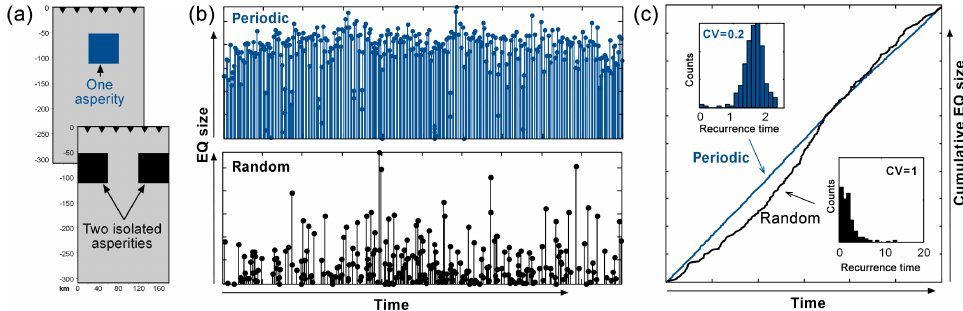
Figure 12. Periodic vs. random rupture behaviour as exemplified by seismotectonic scale models. (a) Model set-up: blue – one asperity; black – two asperities. (b) Analogue earthquake catalogues generated by blue and black models. (c) Cumulative plot of analogue earthquakes sequences and histograms of frequencies. Data and methodological details are published as open-access material in Rosenau et al. (2016).